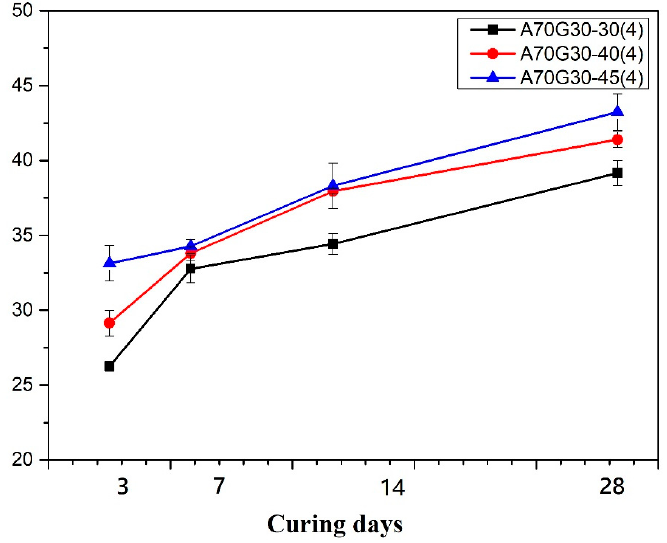
Figure 5. Influence of L/S ration on the compressive strength of A70G30-geopolymer mortar.